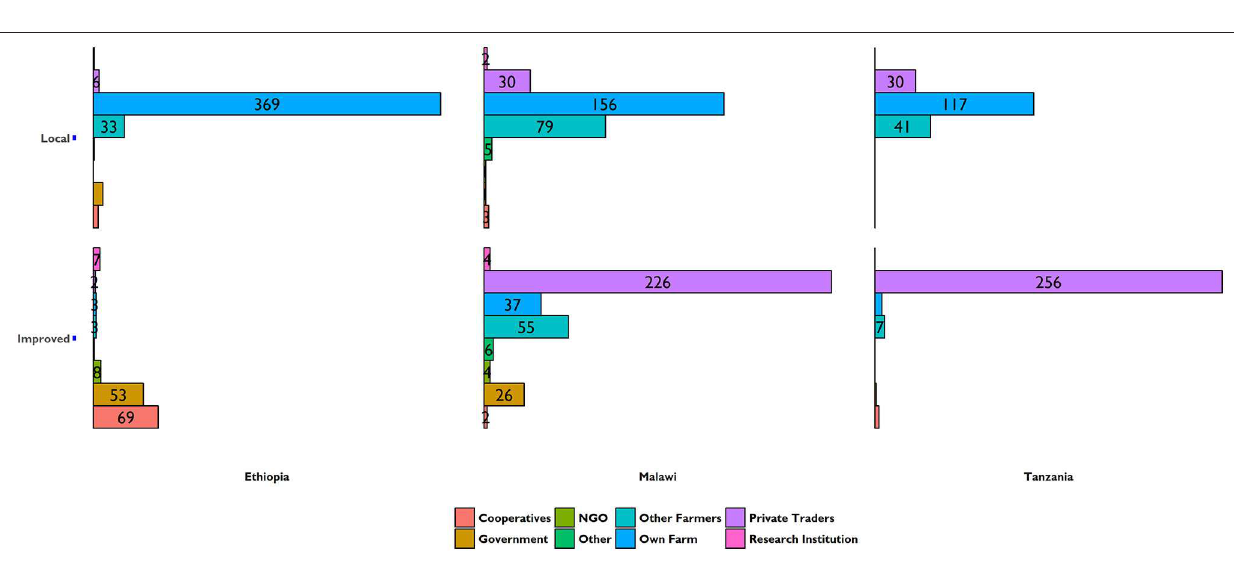
income distribution is, as can be seen from the large standard deviations, highly